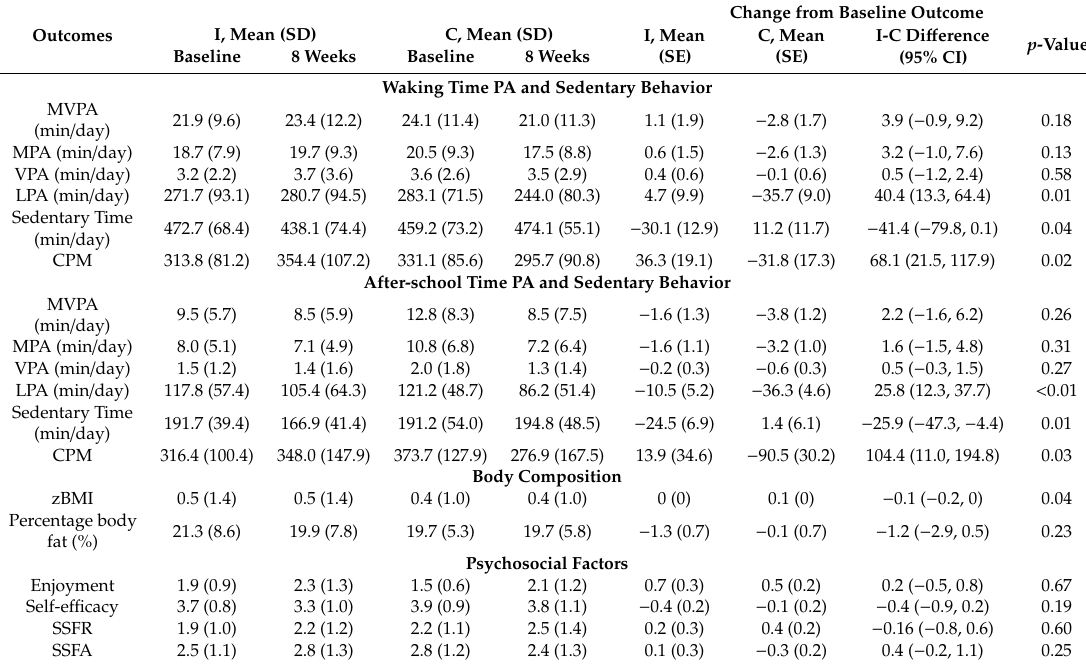
Table 5. Estimated Treatment E ff ects among